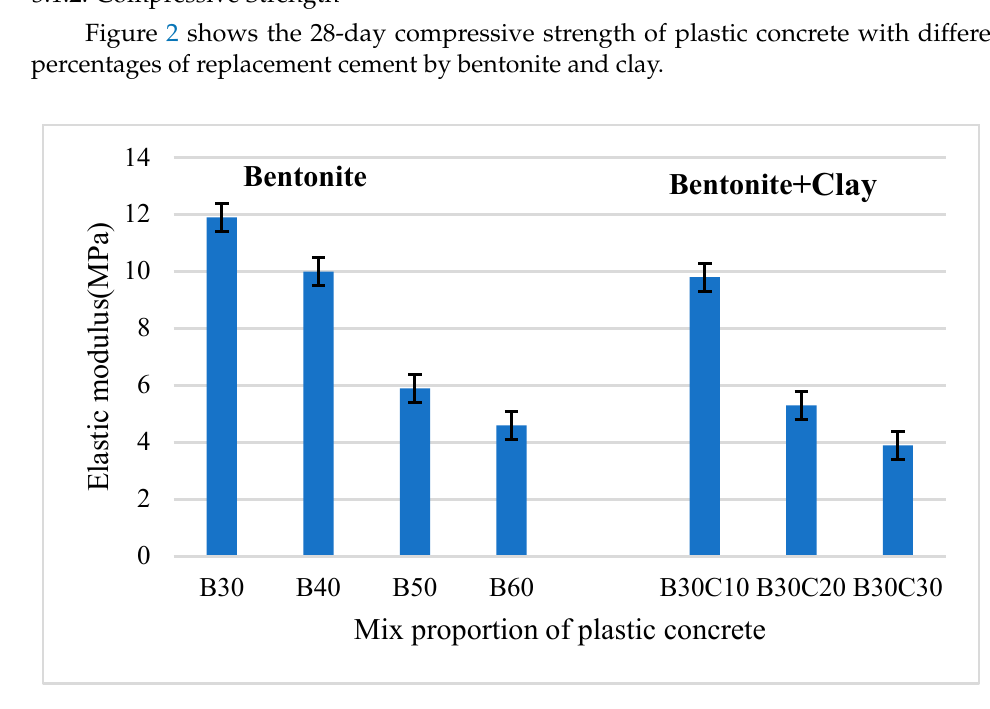
Figure 2. Compressive strength of plastic concrete mixed with bentonite and clay.